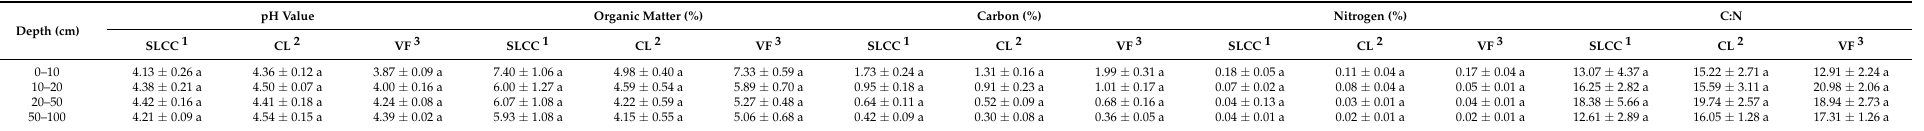
Table 3. Soil chemical properties and carbon and nitrogen concentration at four depths (0–100 cm) in supervised logging with climber cutting plots (SLCC), conventional logging plots (CL), and virgin forest plots